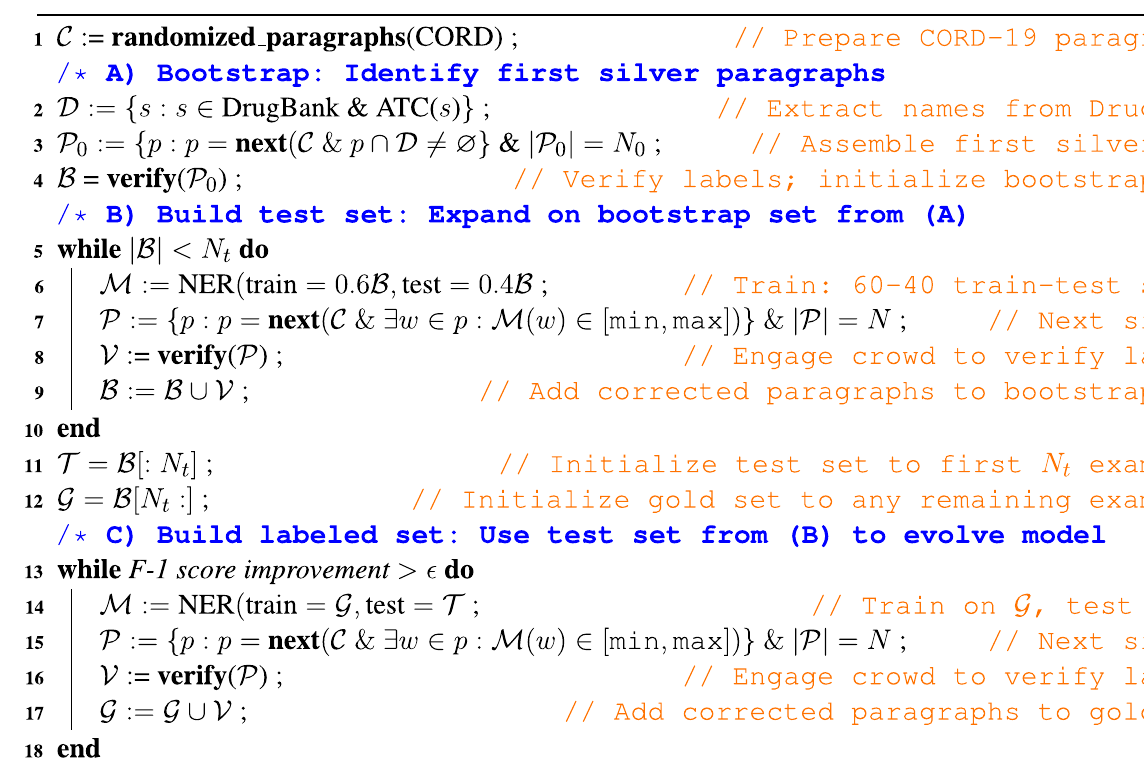
Algorithm 1 | Model-in-the-loop Annotation Work fl